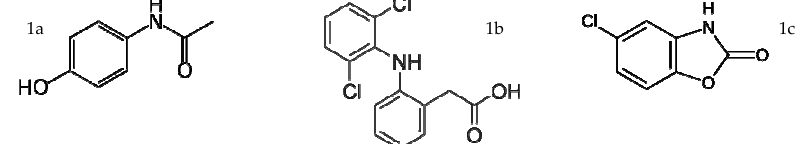
Figure 1. Chemical structures of (1a) paracetamol (1b) diclofenac (1c)